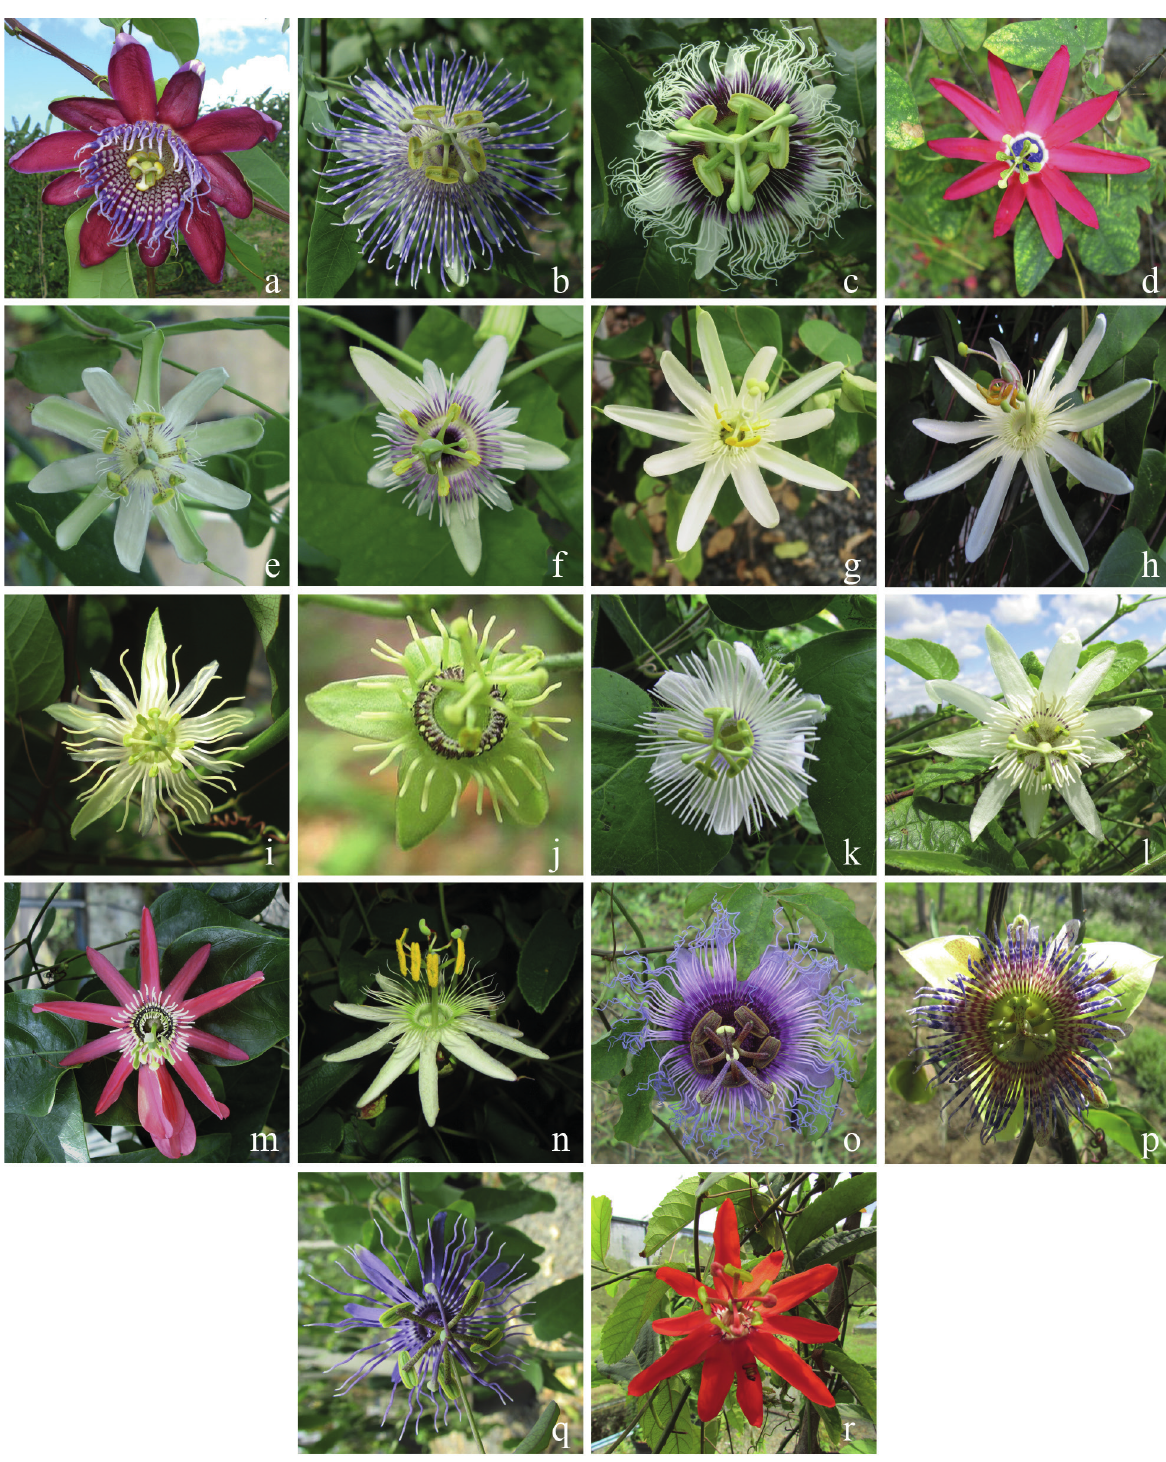
Figure 1 - General view of flowers of 18 Passiflora species used in this study: a ) P. alata , b ) P. gibertii , c ) P. edulis f. flavicarpa , d ) P. edmundoi , e ) P. tenuifila , f ) P. morifolia , g ) P. galbana , h ) P. muchronata , i ) P. rubra , j ) P. suberosa , k ) P. foetida , l ) P. malacophylla , m ) P. racemosa , n ) P. setacea , o ) P. cincinnata , p ) P. maliformis , q ) P. subrotunda and r ) P. coccinea